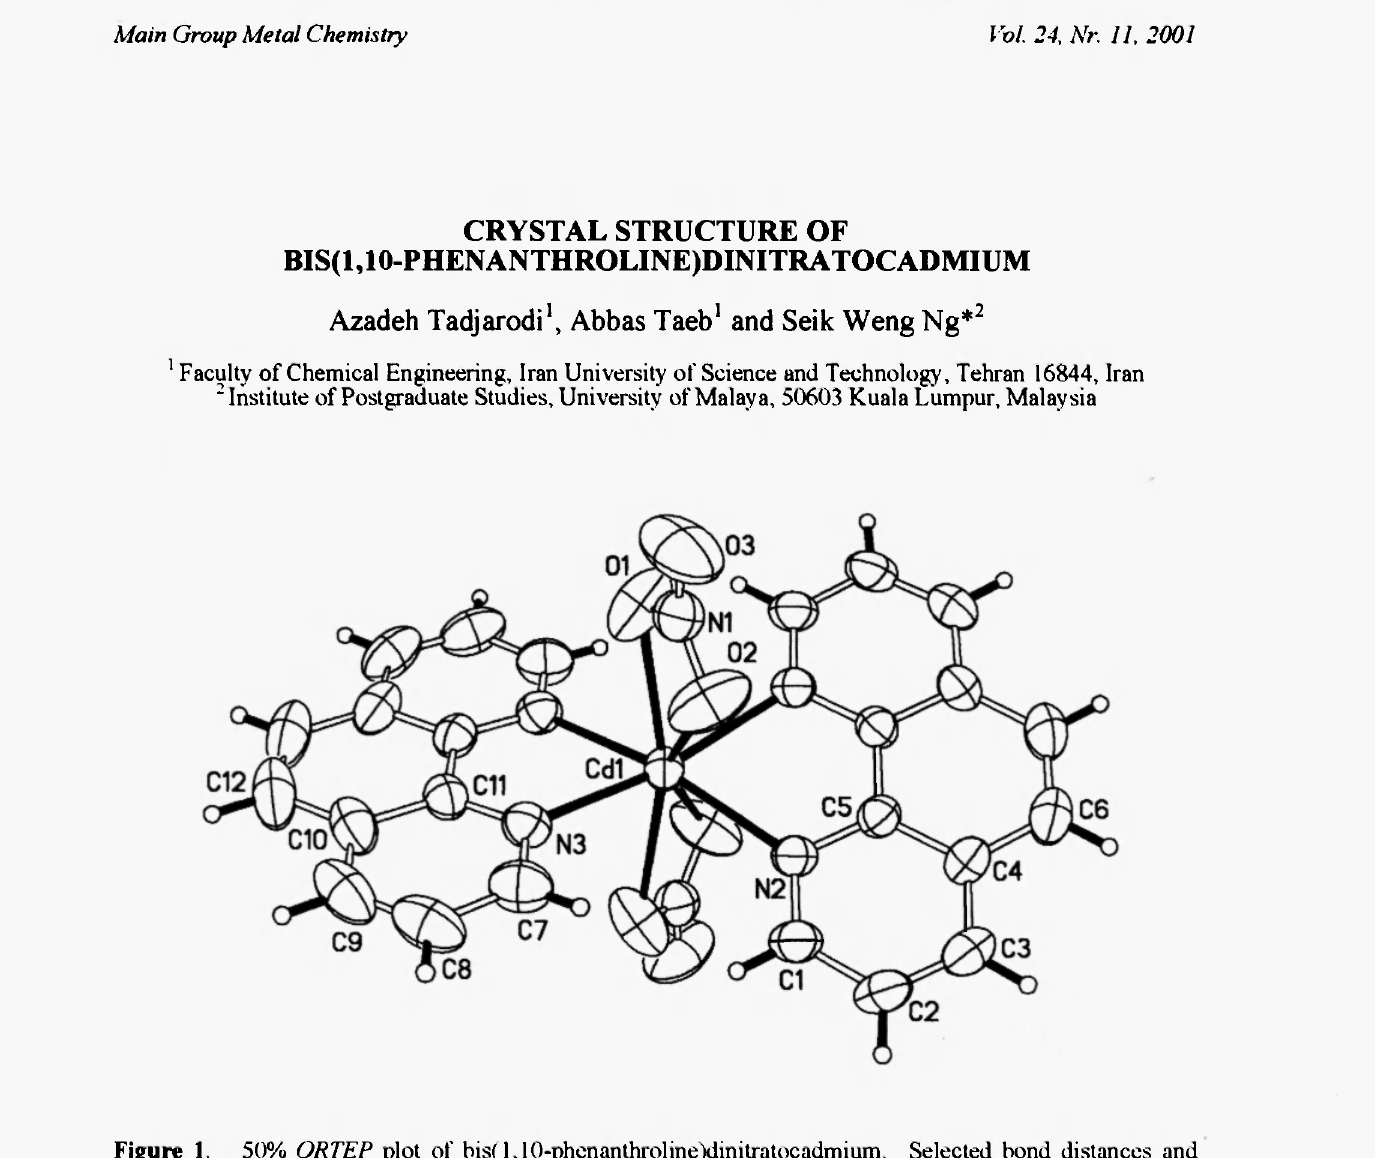
Figure 1. 50% ORTEP plot of bis(l,10-phenanthroline)dinitratocadmium. Selected bond distances and angles: Cdl-N2 2.332(2), Cdl-N3 2.338(3), Cdl-01 2.581(5) Cdl-02 2.568(4) A; N2-Cdl-N2/ 72.6(1). N2-Cd 1-N3 110.1(1), N2-Cdl-N3; 165.0(1), N2-Cdl-Gl 117.9(1), N2-Cdl-01/ 76.1(1), N2-Cdl-02 75.2(1), N2-Cdl-02/ 82.0(2), N3-Cdl-N3i 71.4(1), N3-Cdl-01 90.0(1), N3-Cdl-01< 76.7(1). N3-Cdl-02 119.7(1), N3-Cdl-02/ 84.5(2), Ol-Cdl-Ol/ 163.8(2), 01-Cdl-02 48.1(1), 01i-Cdl-02 137.5(1), 02-Cdl- 02/ 151.6(2)° Symmetry transformation: /= 1 - r, v,